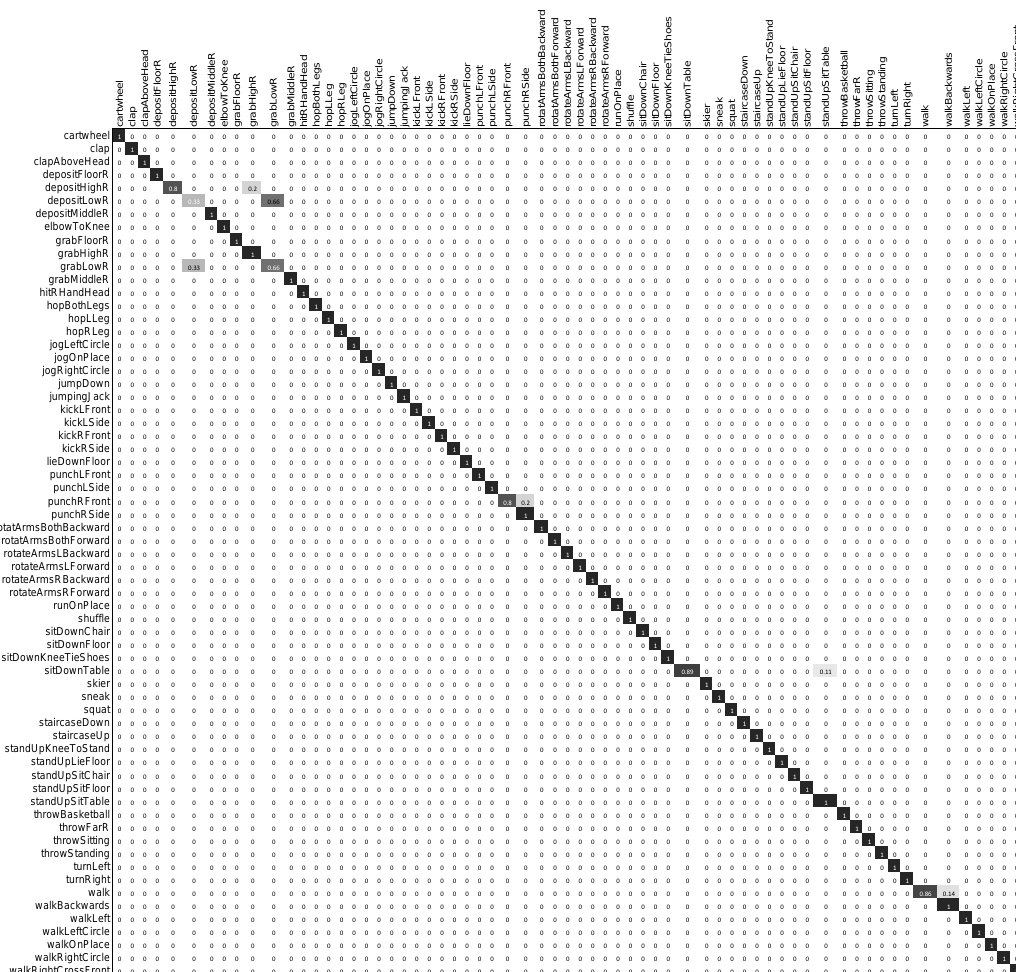
Figure 6. Confusion matrix of our proposed approach on the HDM05-65